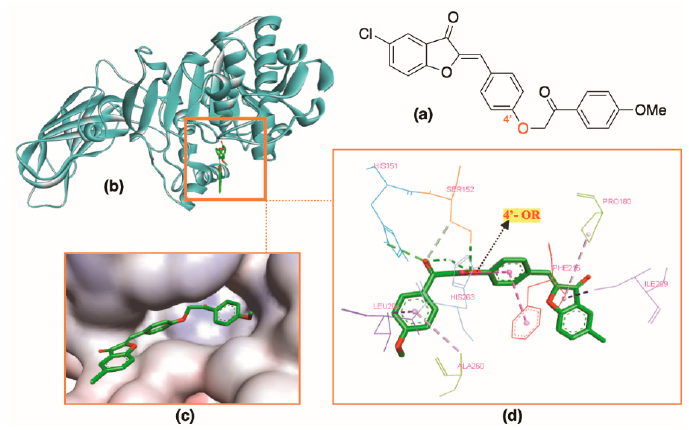
Figure 6. Docking result of A14 with protein (PDB ID: 1LPB): ( a ) 2D structure of A14 . ( b ) A14 inside the active site in the ribbon style. ( c ) A14 in the active site. ( d ) Interactions of A14 and enzyme residues with hydrogen bonds in green and hydrophobic interactions in purple.